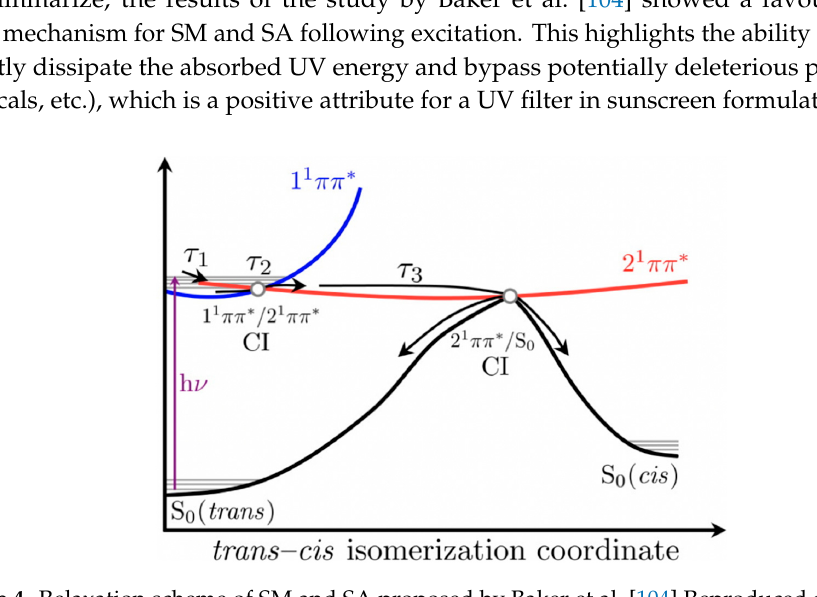
Figure 4. Relaxation scheme of SM and SA proposed by Baker et al. [104] Reproduced and adapted with permission from [104], licensed under CC-BY. © 2015 American Chemical Society.